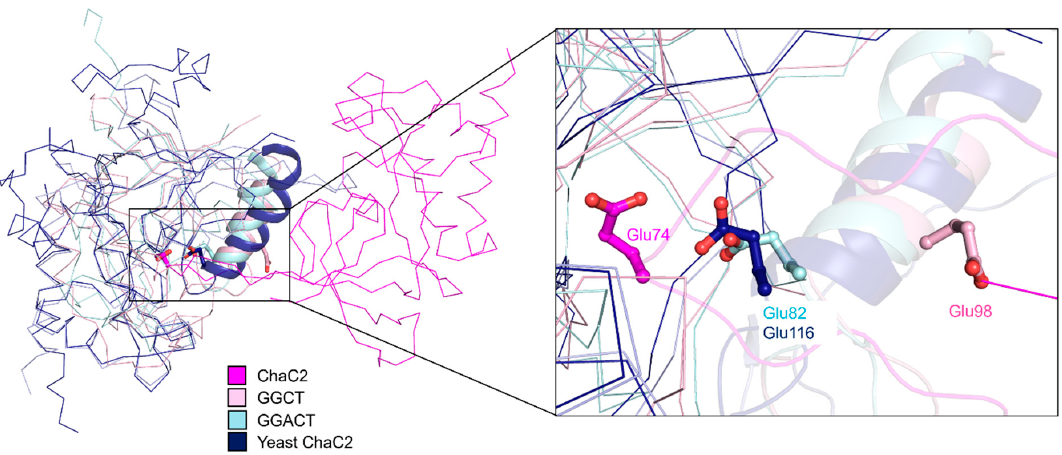
Figure 3. Structural superposition of the structures of human ChaC2, GGCT (PDB ID: 2PN7), GGACT dimer are colored in magenta and light blue, respectively. Human GGCT, GGACT, and yeast ChaC2 structures are colored in light pink, pale cyan, and blue, respectively. The Glu residues in the active site cavities of human ChaC2, GGCT, and GGACT and yeast ChaC2 are shown as stick